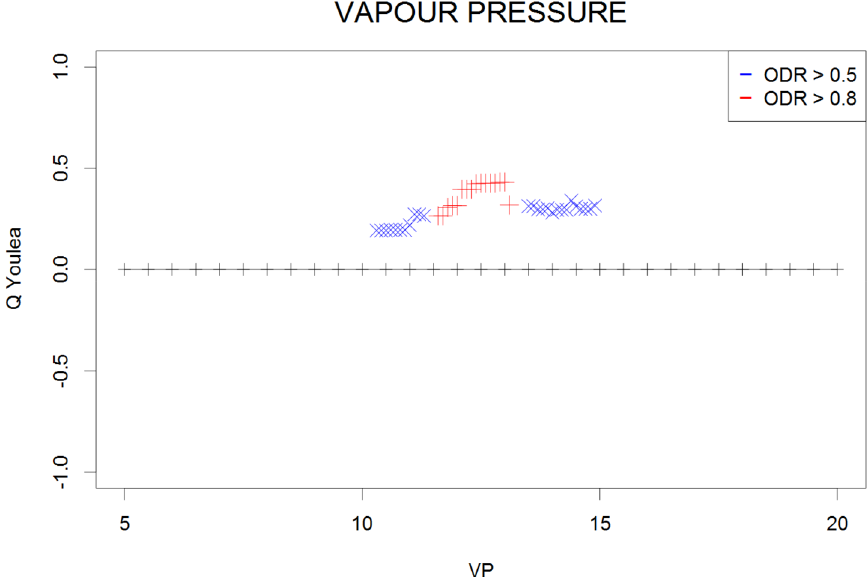
Figure 7. Plot of Q coefficients for different threshold levels of vapour pressure (VP) for the investigated ODR limits (≥ 0.5 and ≥ 0.8).